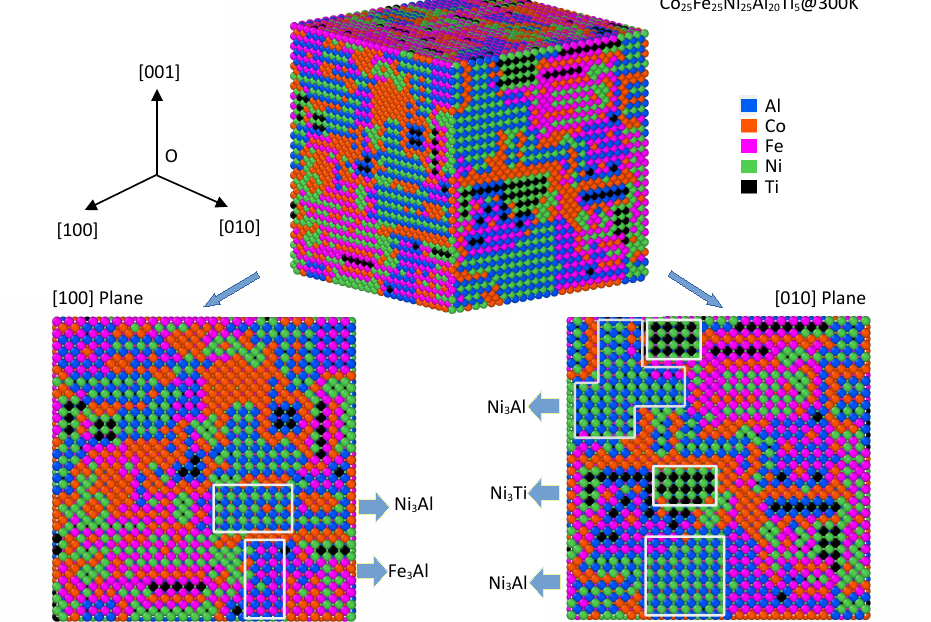
Figure 7. Atomic configuration of AlCoFeNiTi HEAs at 300 K. The [100] and [010] crystal planes of the three-dimension AlCoFeNiTi HEAs are also shown at the bottom. Here, Al, Co, Fe, Ni, and Ti atoms are indicated with blue, orange, purple, green, and black spheres, respectively. The L1 2 -type precipitates are also framed in the